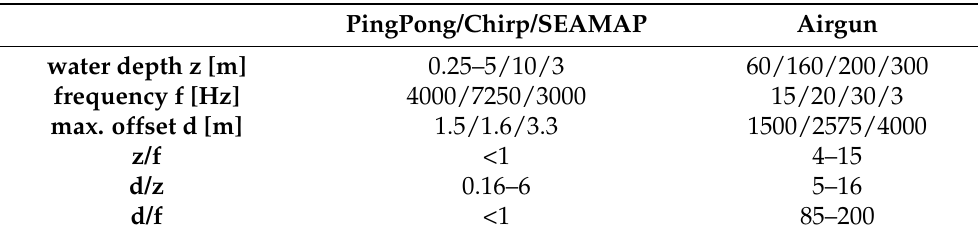
Table A1. Comparison between water depth, offset, and frequency for different marine seismic